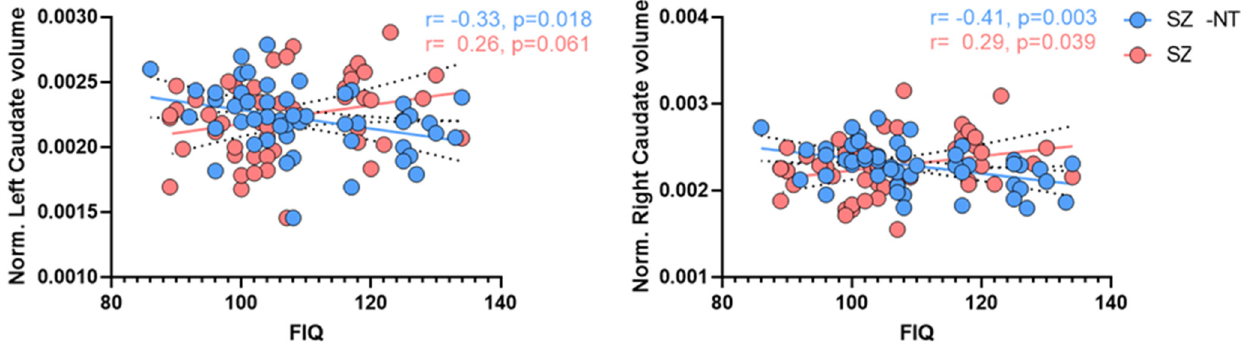
Figure 4. Schizophrenia correlation plots. ( Left ): correlation between normalized left caudate volume and FIQ in SZ ( r = 0.26, p = 0.061) and SZ-NT ( r = − 0.33, p = 0.018). ( Right ): correlation between normalized right caudate volume and FIQ score in SZ ( r = 0.29, p = 0.039) and SZ-NT ( r = − 0.41, p = 0.003). Solid-lines: regression-line (red = SZ, blue = SZ-NT); dashed-lines indicate the 95% confidence intervals for respective regression lines.